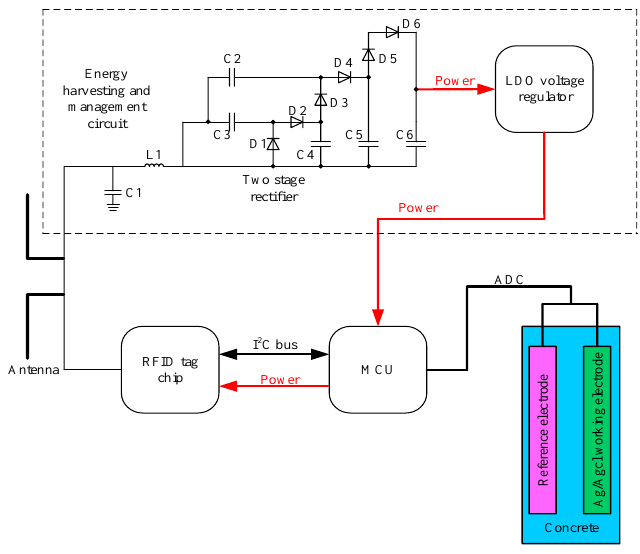
Figure 3. The block diagram of the proposed RFID sensor tag.